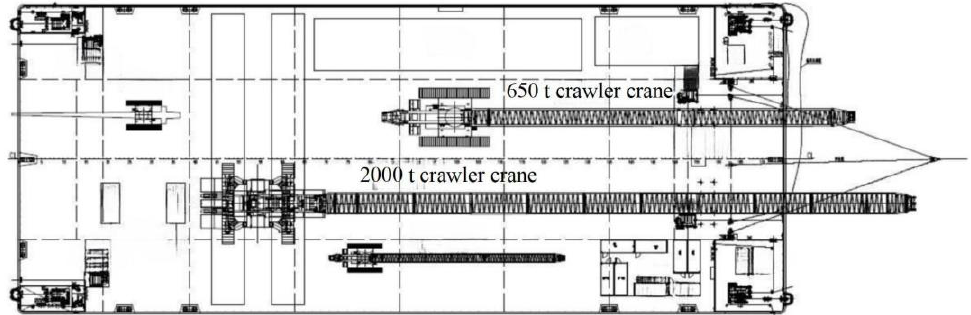
Figure 1. Layout of deck equipment.